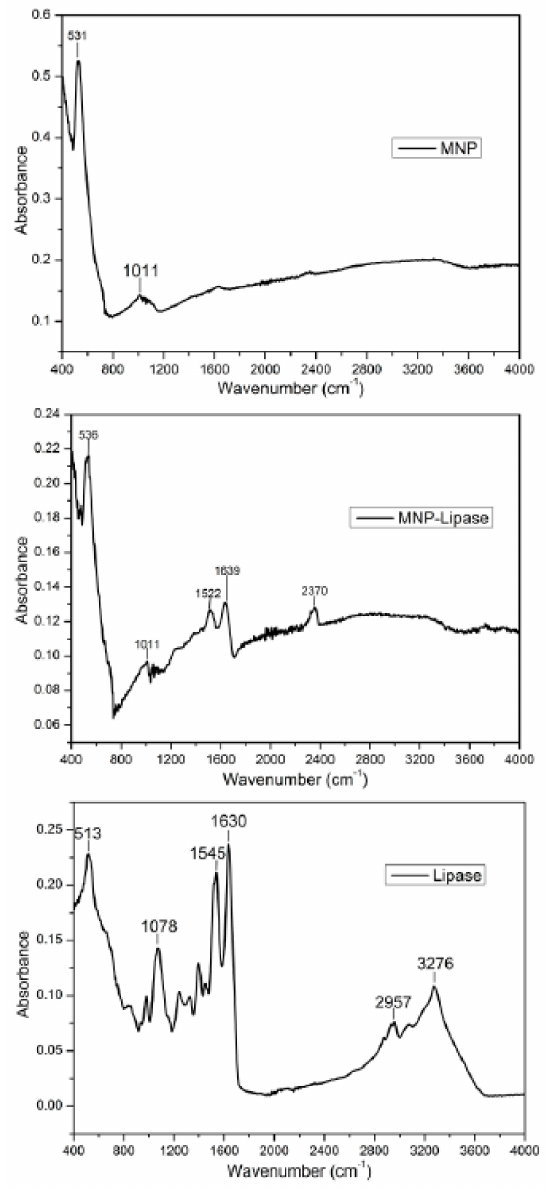
Figure 2. FTIR spectra of functionalised magnetic nanoparticle (MNP), nanoparticle immobilised lipase (MNP-Lipase) and free